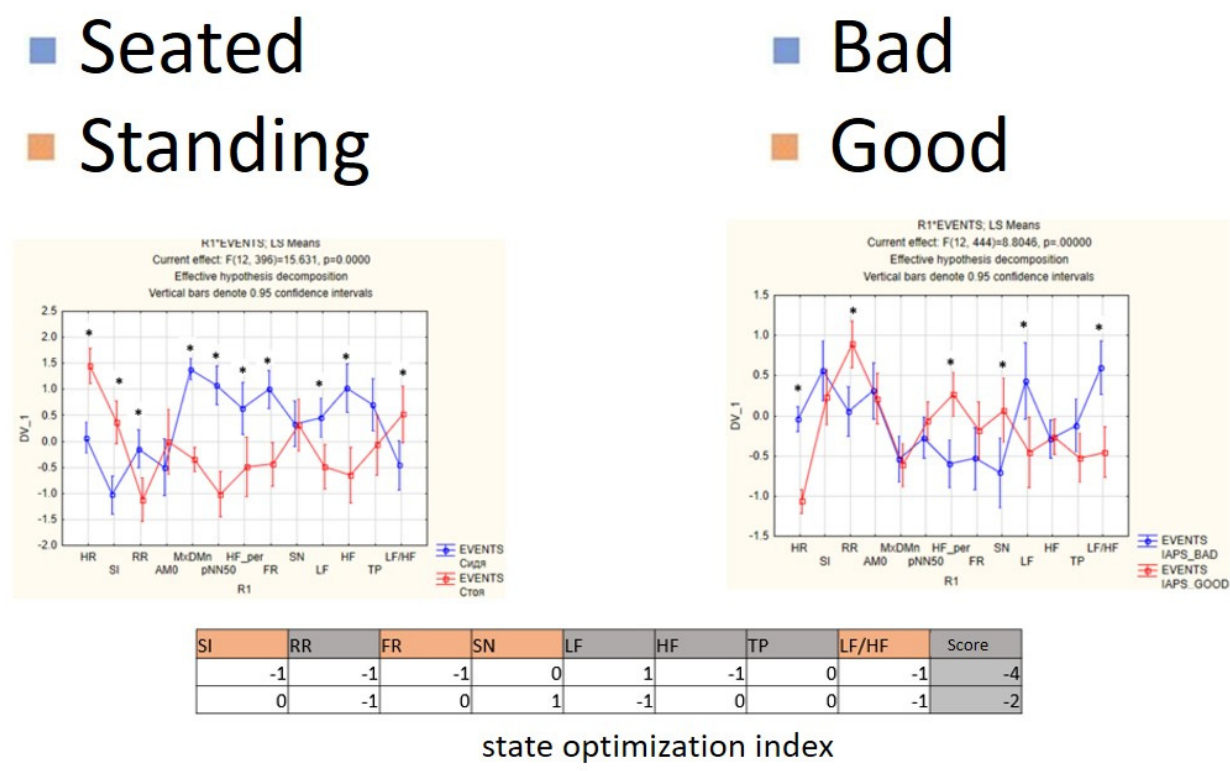
Figure 23. An example of a worsening state in a volunteer, the Basic complex.